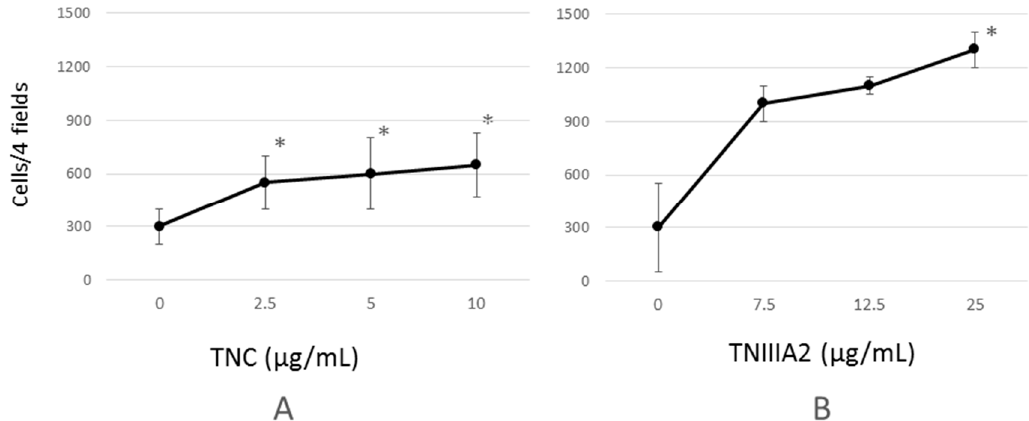
Figure 1. Tenascin C (TNC) and the peptide derived from the alternative splicing domain A2 in TNC (TNIIIA2) dose-dependently promote Colon26-M3.1 invasion. Colon26-M3.1 cells (3.0 × 10 4 cells/ 200 μ L/well) were seeded into the upper compartment of the invasion chamber in the presence of TNC ( A ) or TNIIIA2 ( B ) and were allowed to invade for 24 h. Cells that moved into the lower surface of the membranes were stained with crystal violet and counted for four high powered fields. Data represent the mean of three determinations ± SD. * p < 0.05.